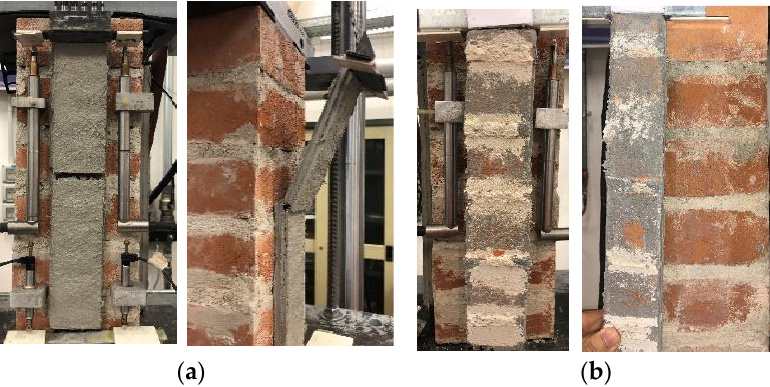
Figure Figure 5. Failure modes of specimen ( a ) DS_300_50_C_1 ( MD mf D ms ) and ( b ) DS_300_50_C_W/D_1 ( D ms